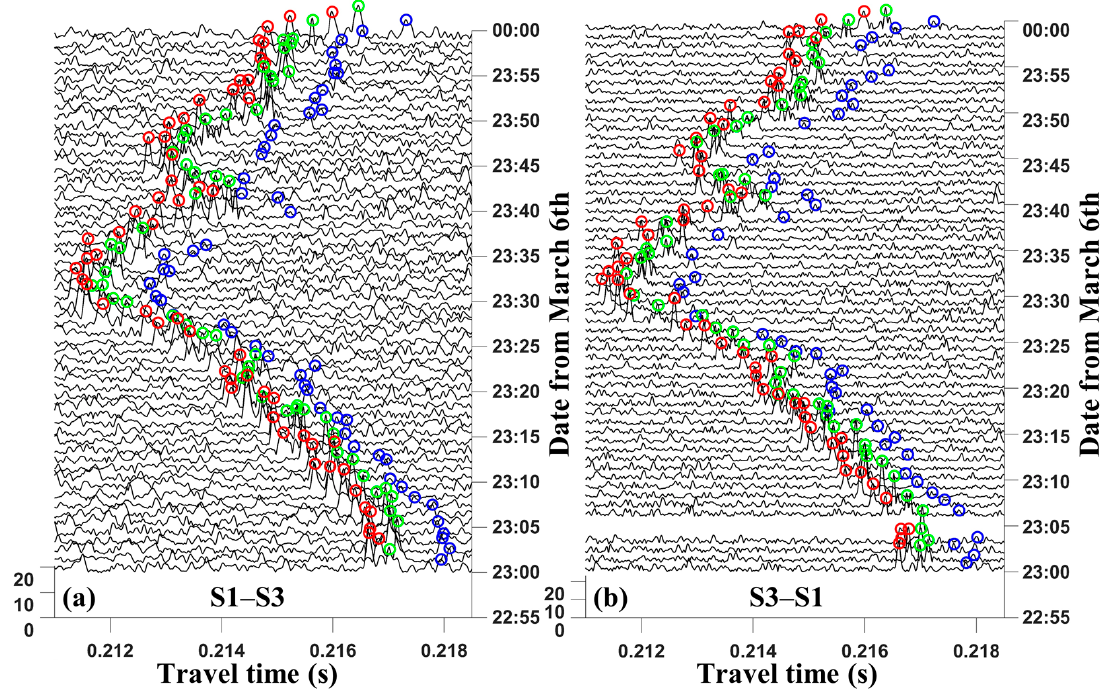
Figure 3. Multi-peak identification of S1 to S3: ( a , b ) are the results of peak extraction from S1 to S3 and S3 to S1 after correlation. The abscissa axis is the travel times of signals; the ordinate axis is the time of sending signals; the peak height is the SNR value. Circles in different colors represent different travel times of the acoustic arrival signals and also match different sound ray paths. Red circles denote first peaks, green circles denote second peaks, and blue circles denote third peaks.